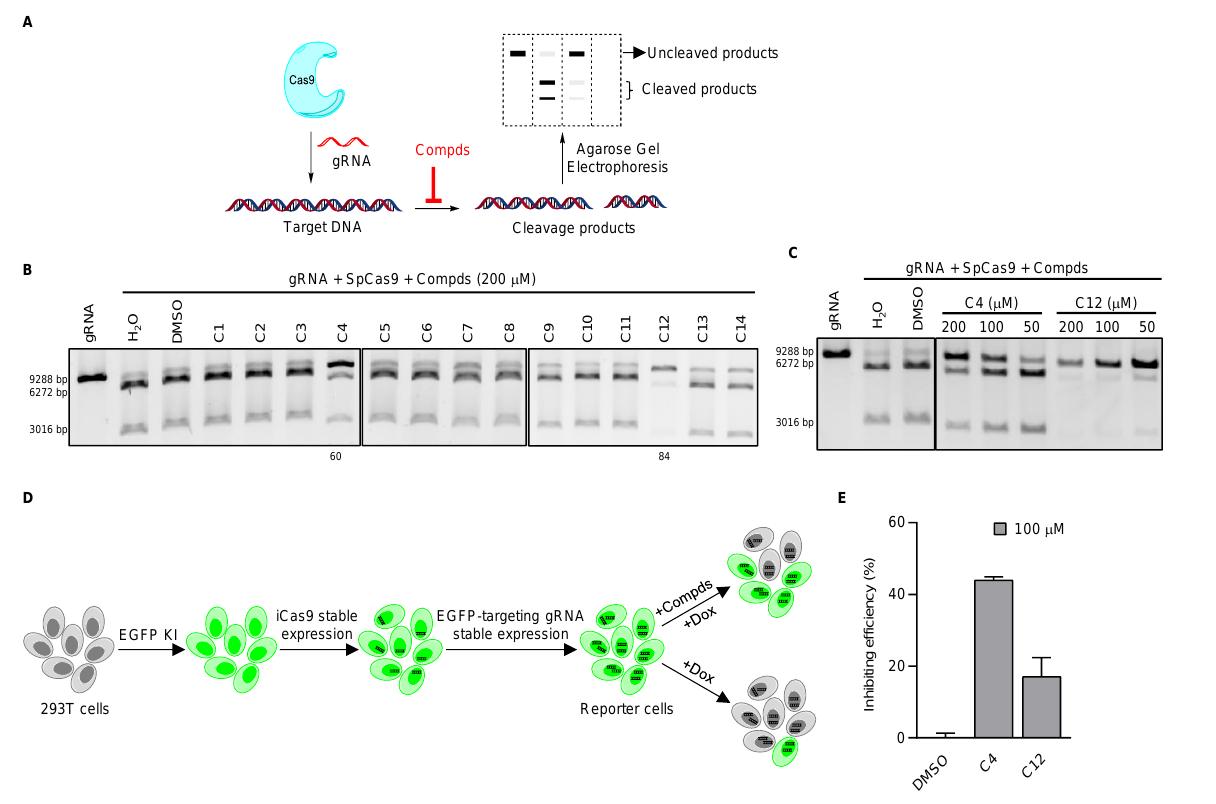
Figure 1. Identification of small-molecule inhibitors of SpCas9 through unbiased screens. ( A ) In vitro Cas9 cleavage assays were carried out in the presence of different compounds. Cleavage products were then resolved by agarose gel electrophoresis. ( B , C ) SpCas9–gRNA (58.8 nM) mixtures containing various compounds at the indicated concentrations were incubated with a linearized plasmid (3.48 nM) for in vitro DNA cleavage assays. The number indicates the compound’s inhibition rate. ( D , E ) To monitor the cleavage activity of SpCas9 in live cells, we generated reporter 293T cells where EGFP was knocked into the H2AX locus, then tetracycline-inducible Cas9 (iCas9) and an EGFP-targeting gRNA were stably expressed in the cells. The reporter cells were induced with doxycycline (2 μ g/mL) in the presence of various compounds (100 μ M) and examined for EGFP+ cells by flow cytometry after 72 h ( D ). Results were quantified and plotted in ( E ). Error bars represent SD from two biological repeats.